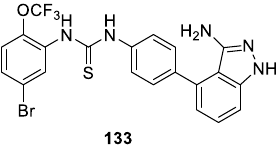
Figure 34. Chemical structure of 1 H -indazole-3-amine derivative 133 .